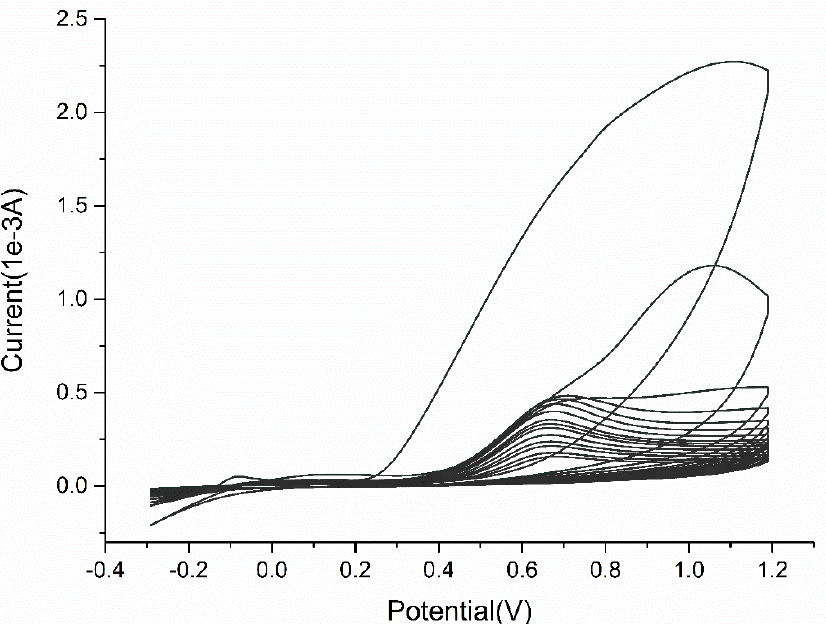
Figure 2. Cyclic voltammogram for the electropolymerization of MIP film on Au surface. Scan rate: 50 mV/s; number of scans: 30; potential range: − 0.3 V to 1.2 V.